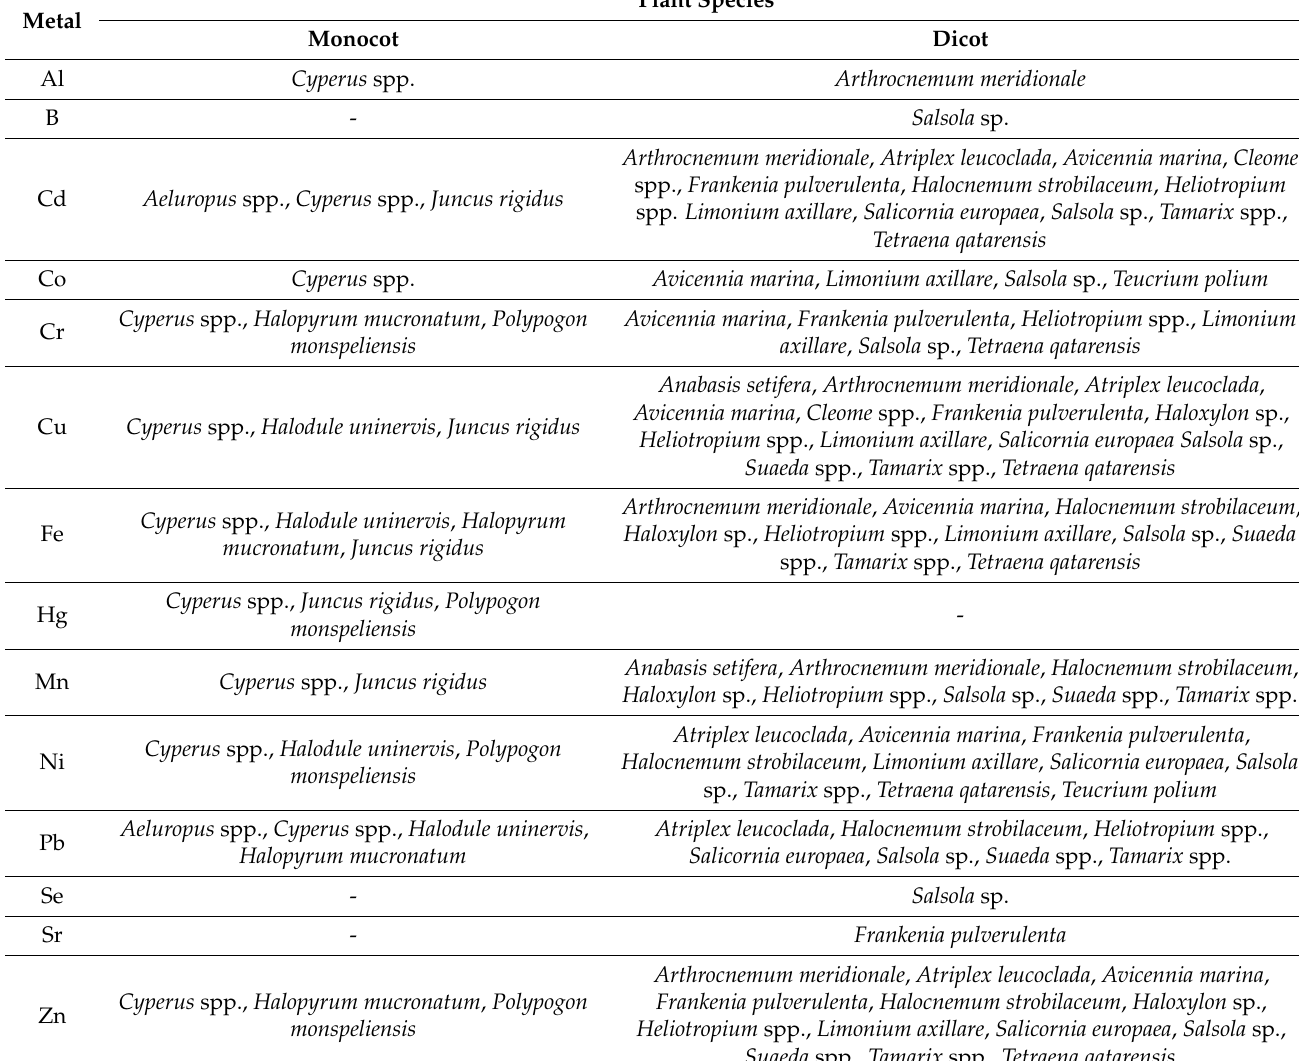
Table 3. List of halophyte plants in Qatar that proved efficient in phytoremediation of heavy